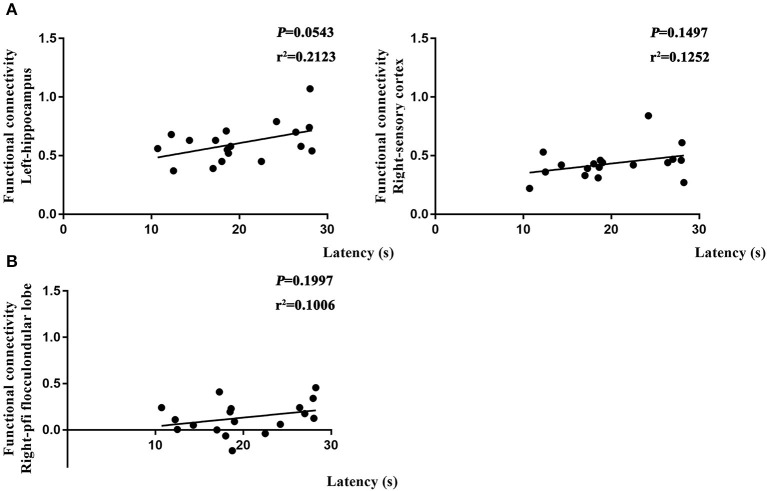
Relationship between functional connectivity (FC) and behavior performances on day 31. (A) Correlation analysis in L and NS groups. (B) Correlation analysis in L and L + S groups. Pearson's correlation was used with p < 0.05 for statistical significance and r2 for correlation.